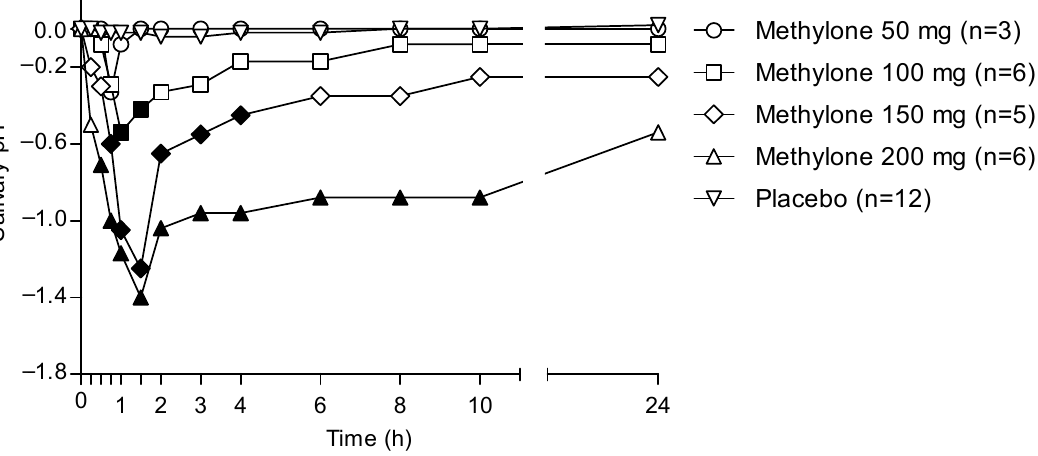
Figure 4. Time pro fi les of OF pH following controlled administration of di ff erent methylone doses. Filled symbols indicate signi fi cant di ff erences in that time point with respect to each dose baseline.